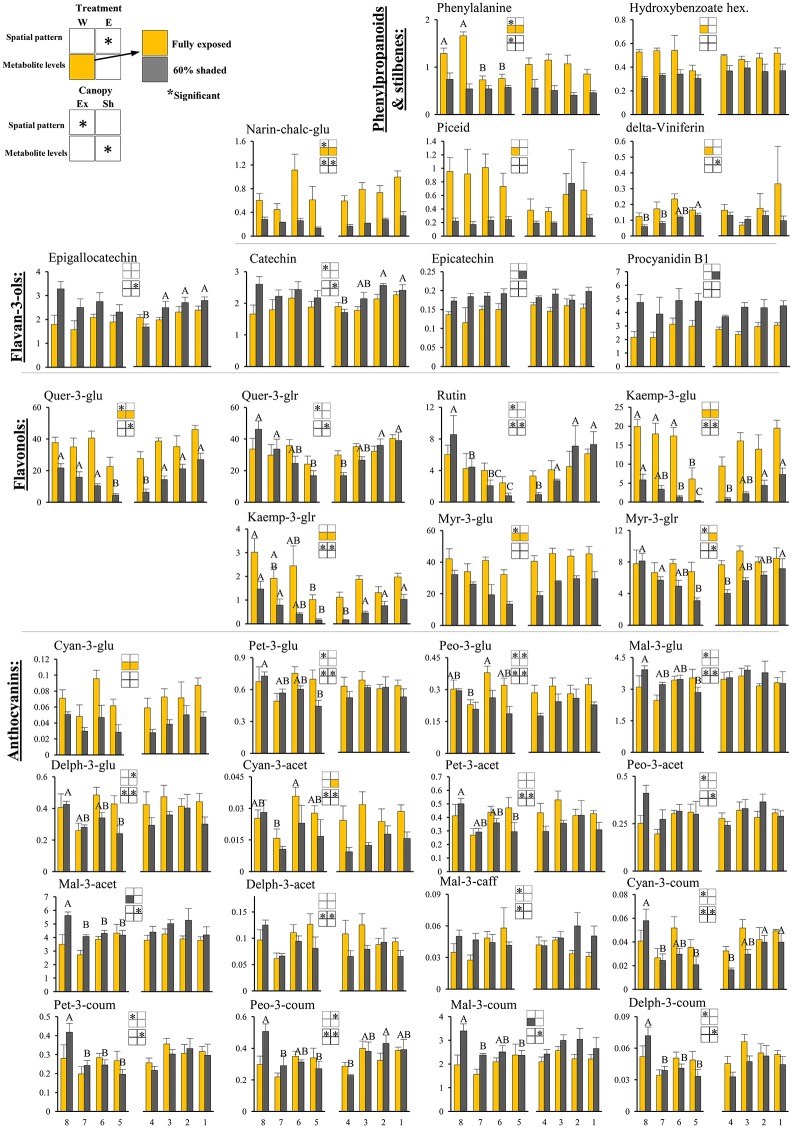
Cluster spatial level results for phenylpropanoid metabolites detected by UPLC-QTOF-MS in berry skin tissues sampled from different cluster orientations and shading treatments. Included are pivotal phenylpropanoids and stilbenes, flavan-3-ols, flavonols, and anthocyanins found to be significantly affected by SI levels, cluster position and/or cluster orientation. Levels represent relative abundance based on ion count. Numbers on the X axis represent cluster orientations. Yellow bars represent fully exposed clusters, and dark gray bars represent 60% shaded clusters. Error bars are standard error (n = 4). Bars of the same cluster location and treatment, marked by different letters, represent significantly different values (α < 0.05). Information given in the boxes details the significant effects of treatment (upper box) for clusters located on the east (E) and the west (W) side of the canopy, as well as canopy side (lower box), on the spatial pattern and profile levels of metabolite accumulation in fully exposed (Ex) and 60% shaded (Sh) clusters. Asterisks in upper box indicate a significant effect of treatment on the spatial pattern of compound accumulation. Yellow and gray boxes indicate a significantly higher overall compound level in the exposed and 60% shaded treatments, respectively. Asterisks in lower boxes indicate a significant effect of canopy side on the spatial pattern and overall compound levels. Illustrations of the daily irradiance levels in the corresponding cluster orientation are given in Figure 3A.